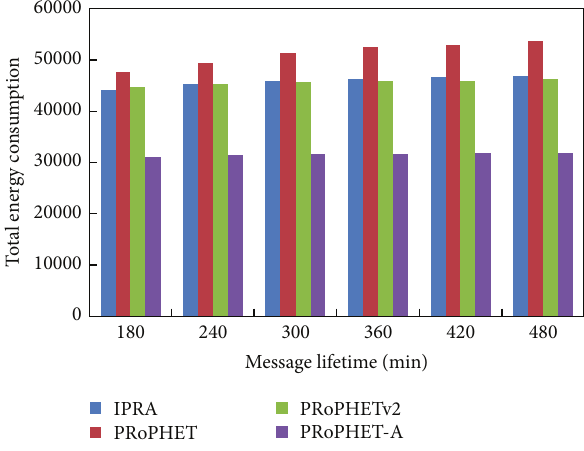
Figure 18: Total energy consumption (TEC) versus message life-